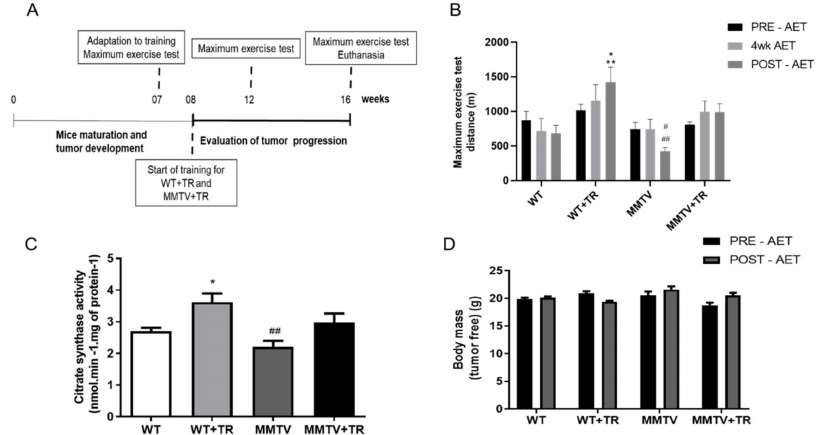
Figure 2. Experimental design, Maximum exercise test, Citrate synthase activity and Body mass to MMTV-PyMT non-cachectic mice. ( A ) Experimental design; Groups: WT—wild type sedentary; WT+TR—wild type trained; MMTV—mammary cancer sedentary; MMTV+TR—mammary cancer trained. ( B ) Maximal distance running in the maximal exercise test before aerobic exercise training protocol (PRE-AET), four weeks of aerobic exercise training protocol (4wk-AET) and after the end of aerobic exercise training protocol (POST-AET); data are reported as means ± SEM, * p < 0.05 vs. WT POST-AET and 4wk AET, MMTV PRE-AET and 4wk AET and ** p < 0.001 vs. MMTV